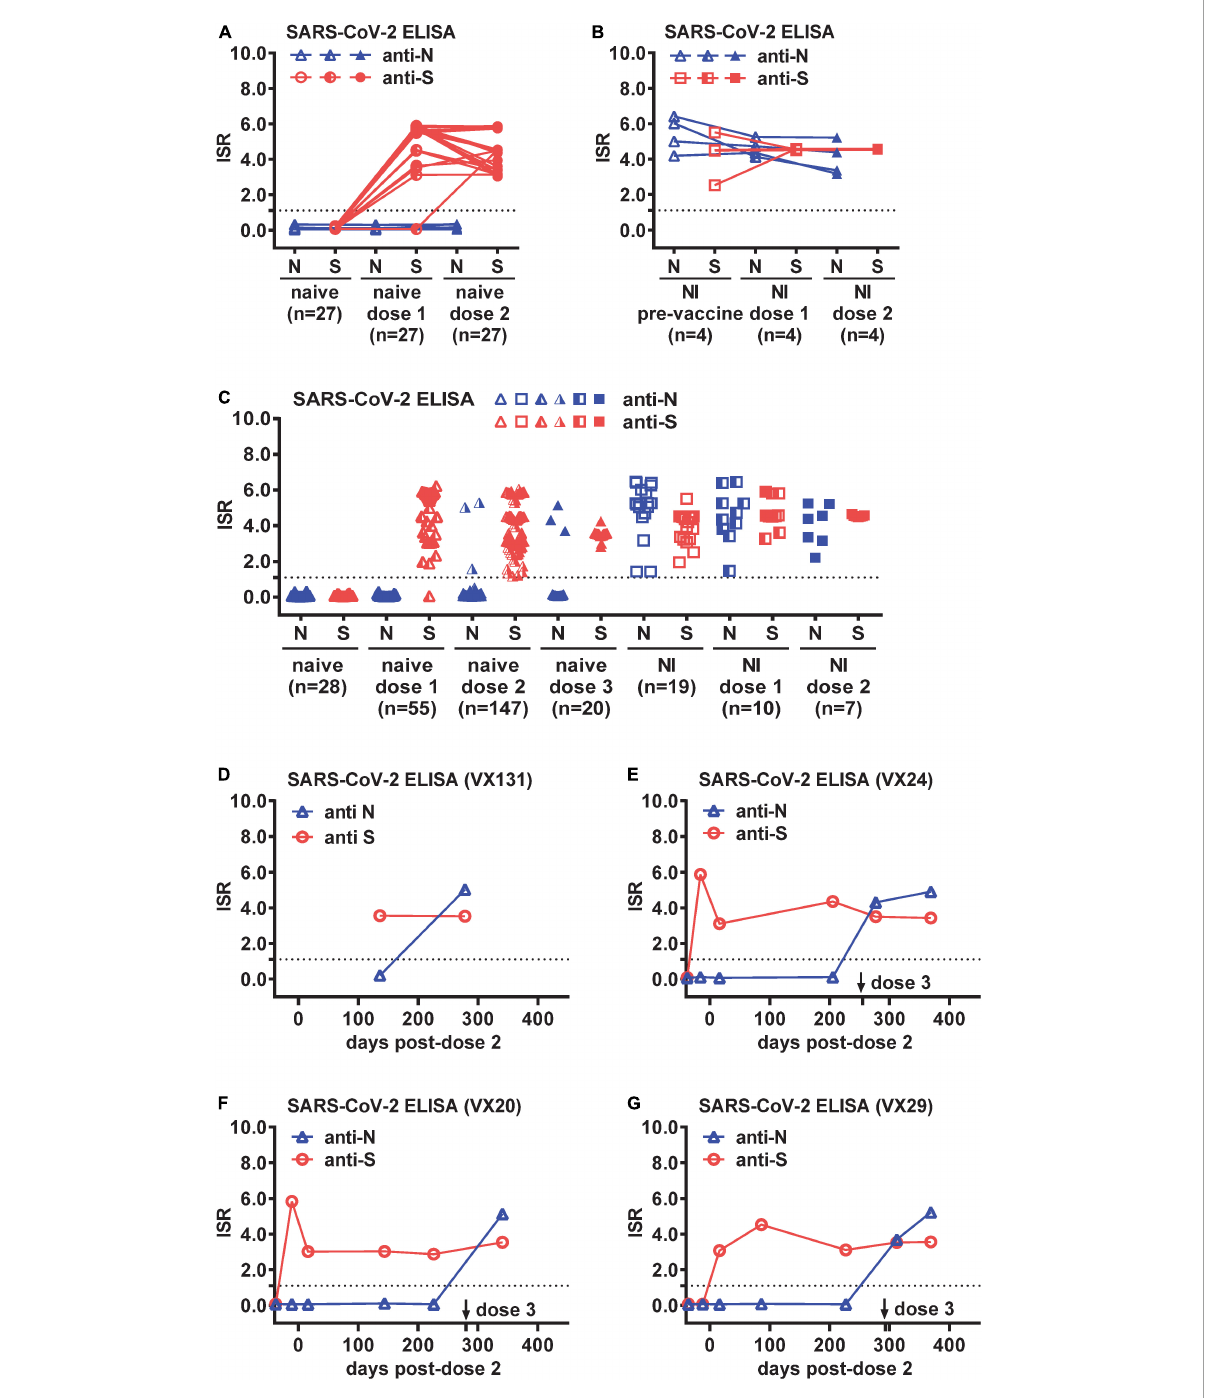
FIGURE1 Breakthrough infections (BTIs) identified by anti-N and anti-S ELISAs among COVID-19-naïve vaccinees. Results of anti-N and anti-S ELISAs of sequential plasma samples from (A) COVID-19-naïve ( n = 27) and (B) SARS-CoV-2 natural infection (NI) ( n = 4) panels before and after one and two doses of a mRNA vaccine (Moderna or Pfizer). (C) Results of anti-N and anti-S ELISAs of single or sequential plasma samples from COVID-19-naïve participants following one ( n = 55), two ( n = 147), or three ( n = 20) doses of a mRNA vaccine, and controls from COVID-19-naïve ( n = 28), NI ( n = 19), and NI followed by one ( n = 10) or two ( n = 7) doses of a mRNA vaccine. (D–G) Results of anti-N and anti-S ELISAs of sequential plasma samples from four COVID-19-naïve participants (VX131, VX24, VX20, VX29) with a BTI identified by anti-N antibody seroconversion following two or three doses of Moderna vaccine. Dotted lines indicate the cut-off of immunological status ratio (ISR) values for ELISAs. Data are the mean of duplicates from one